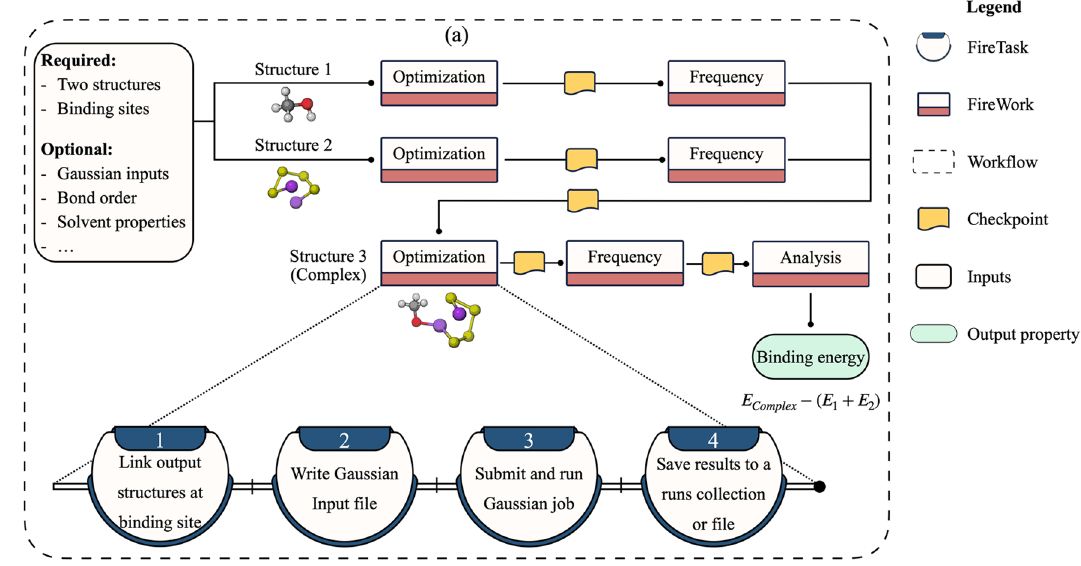
Figure 6. Workflow diagram for the binding energy